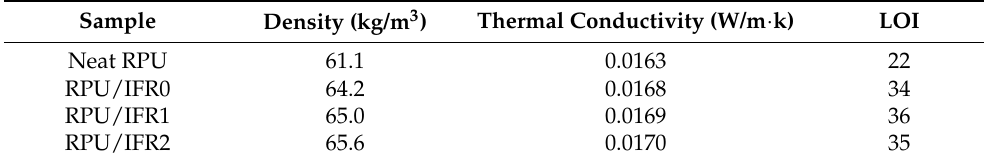
Table 4. Physical properties and LOI test results of neat RPU and flame retardant RPU foam